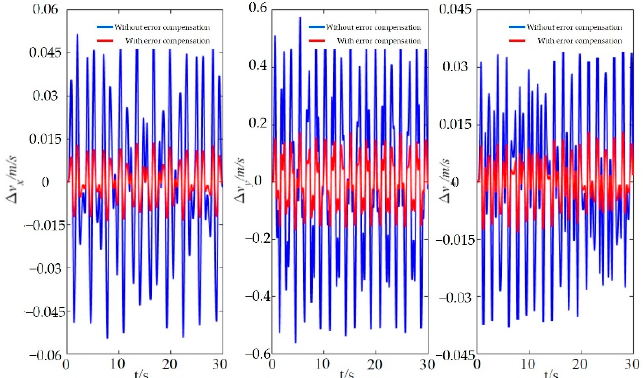
Figure 18. The maximum sculling errors in the X-, Y-, and Z-axis directions are 0.055 m/s, 0.58 m/s, and 0.038 m/s, respectively, without sculling error being compensated, and they are 0.013 m/s, 0.18 m/s, and 0.014 m/s, respectively, with sculling error being compensated, decreasing by 76.4%, 70.0%, and 63.2%, respectively. The sculling error effect is reduced significantly and the monitoring accuracy is improved effectively.